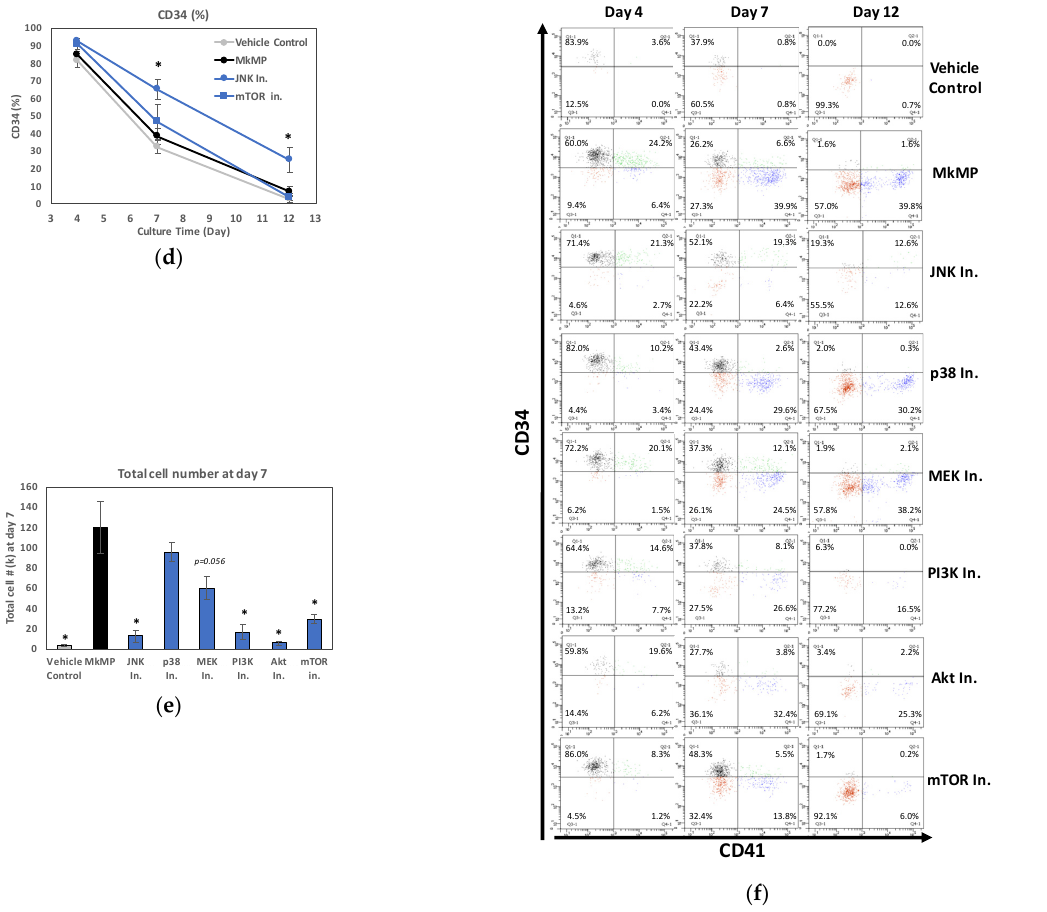
Figure 5. Impact of signaling inhibitors on MkMP-induced Mk differentiation. CD34 + HSPCs were pretreated with a signaling inhibitor, or solution without an inhibitor (MkMP control), and were co-cultured with MkMPs or vehicle control. Cells were harvested for flow cytometric analysis for ( a , b ) CD41 expression at day 7 and day 12, ( c ) CD42b expression at day 12, or ( d ) CD34 expression at days 4, 7, and 12. ( e ) Representative flow cytometric dot plots for CD34 and CD41 expression at day 4, 7 and 12 with quadrant gates. ( f ) Total cell numbers were measured at day 7. Error bars in ( a – c ) represent the standard error of mean of 6–8 biological replicates, while error bars in ( d – f ) represent the standard error of mean of 3 biological replicates. * p < 0.05, ** p < 0.01, *** p < 0.001 (compared to MkMP